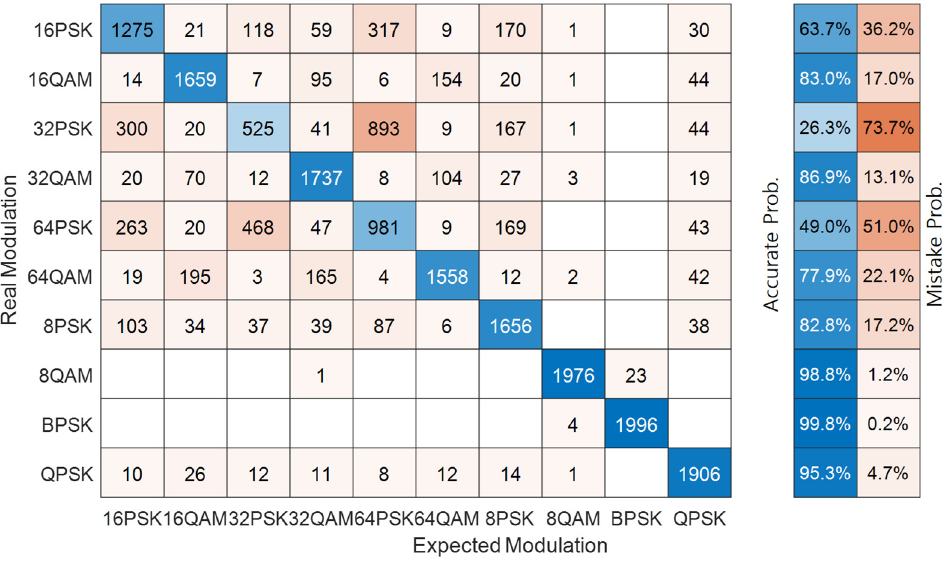
Figure 15. PMI accuracy table of constructed CNN algorithm.